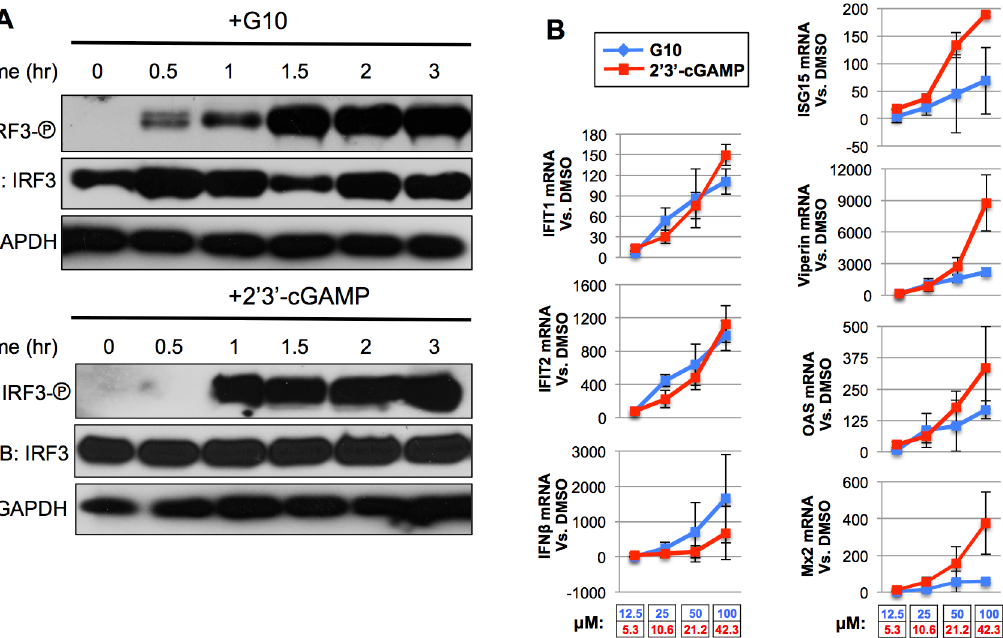
Fig 9. Comparative Kinetics and Dose-Dependence of Innate Immune Activation by G10 and 2 ’ 3 ’ -cGAMP. (A) Immunoblot of lysates from THF-ISRE cells following exposure to G10 (100 μ M) or transfected 2 ’ 3 ’ -cGAMP (42.3 μ M) for indicated time showing phosphorylation status of IRF3 S386, total IRF3, and GAPDH. (B) mRNA synthesis of indicated genes in THF following 8h exposure to indicated concentration of G10 (blue) or 2 ’ 3 ’ -cGAMP (red). Indicated values represent average mRNA fold change ± SD from duplicate experiments relative to cells exposed to 1% DMSO.